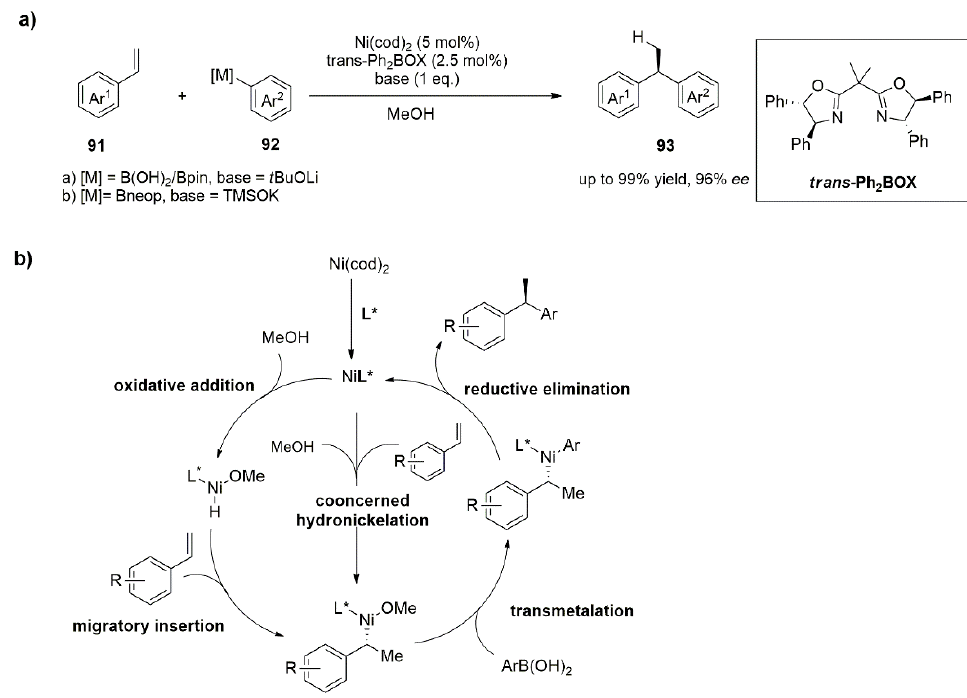
Figure 38. ( a ) Synthesis of chiral 1,1-diarylethanes ( 93 ) trough Ni/ trans-Ph 2 BOX. Catalyst are generated in situ. ( b ) Mechanism of concerted hydronickelation.